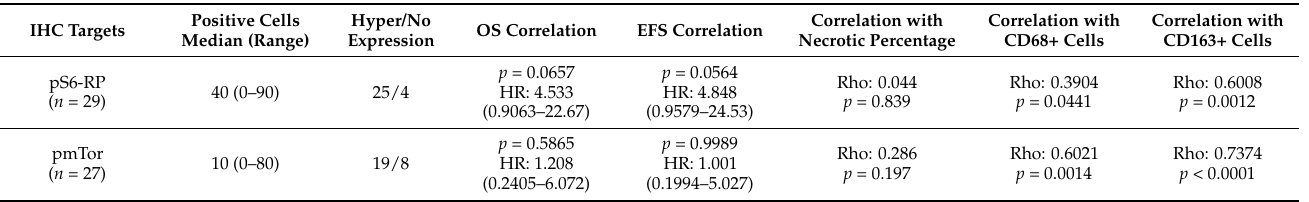
Figure 5. Examples of immunohistochemical staining with hypoxic markers ( upper panels : phospho-mTor (pmTor), pS6-RP, HIF-1 α and CAIX and their paired controls) and macrophagic markers ( bottom panel : CD68 and CD163 with their paired controls). Scalebar = 20 µm, black arrows show examples of intra-tumor giant cells.